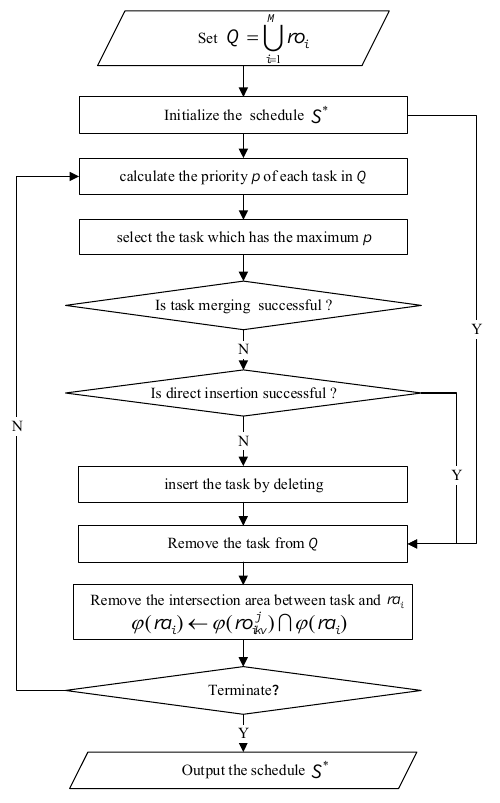
Figure 4. The algorithm of GC-DAHA